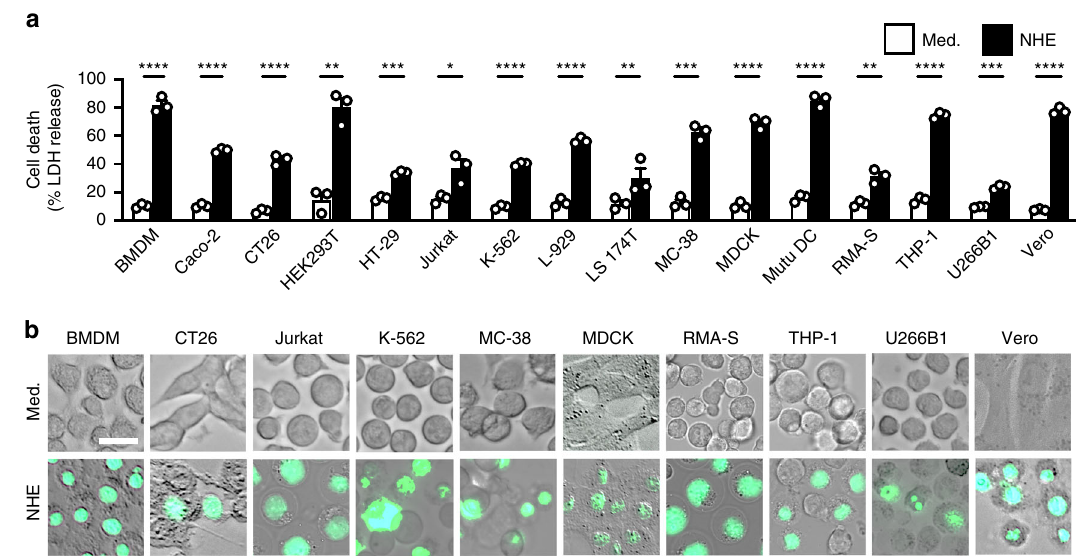
Fig. 7 NHE induces cell death in multiple cell lineages from different species. a Death of various cell types left untreated or assessed 3 h after treatment with NHE. b Bright fi eld and fl uorescent (SYTOX) images of cell lines left untreated or assessed 3 h after treatment with NHE. Green indicates dead cells b . Scale bar, 20 μ m b . * P < 0.05, ** P < 0.01, *** P < 0.001, and **** P < 0.0001 (student ’ s unpaired t test a ). Each symbol represents an independent experiment a . Data are representative of three independent experiments ( n = 3 in a , b ; mean and s.e.m. in a ). Source data are provided as a Source Data fi